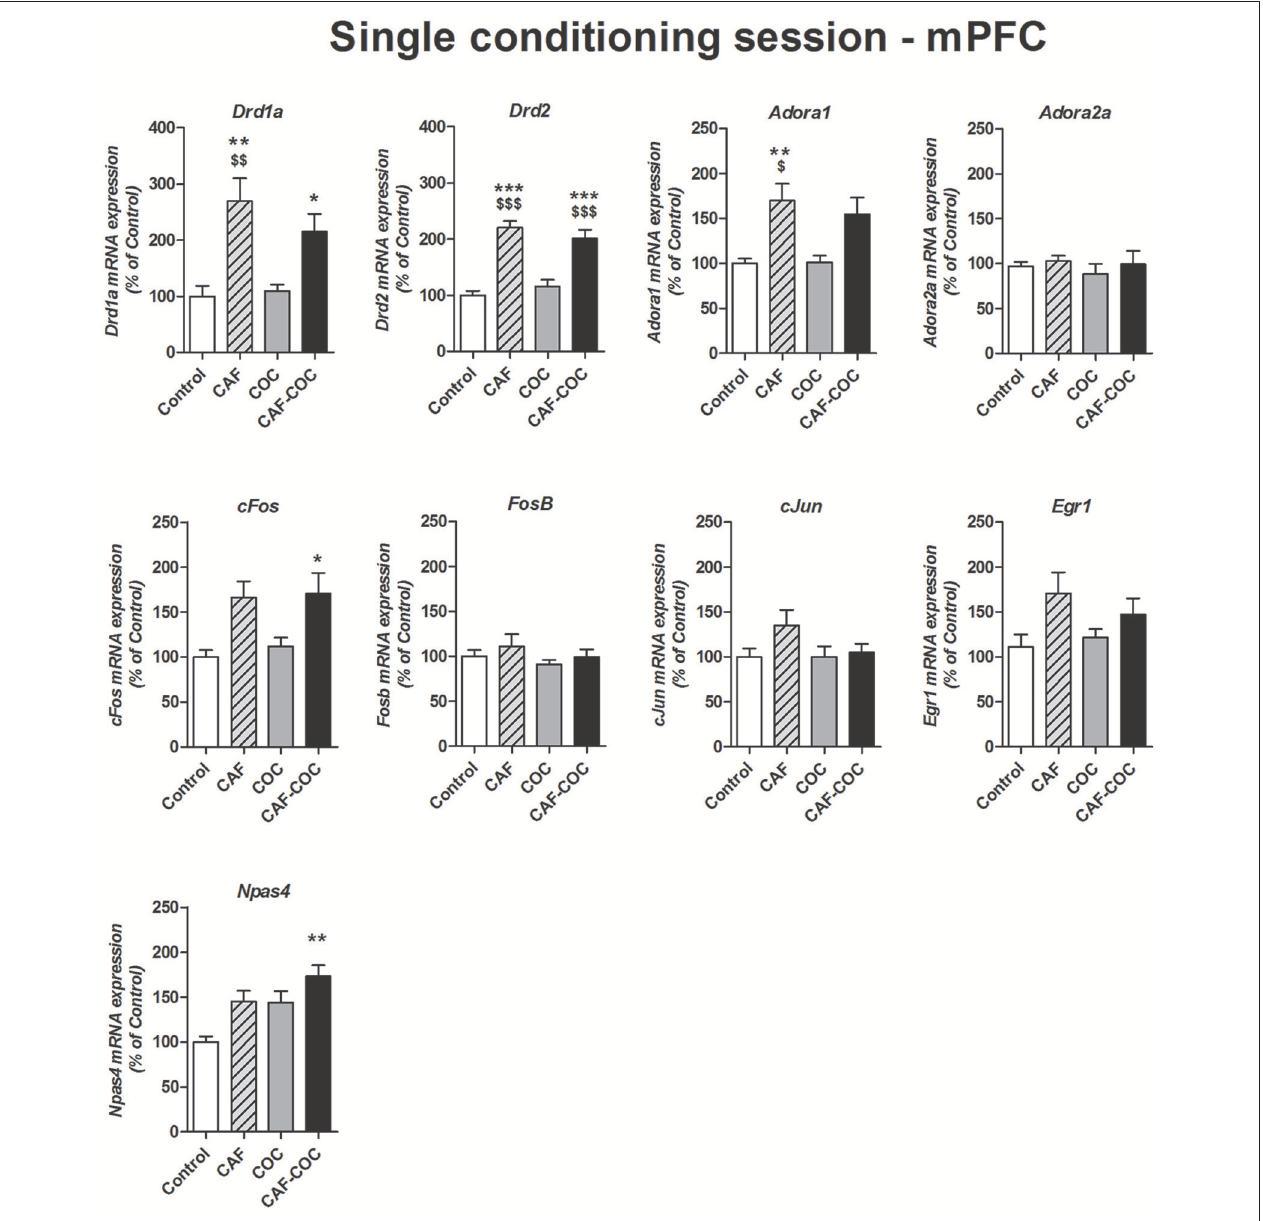
FIGURE 5 | Gene expression changes in the mPFC following a single conditioning session of the CPP. Dopamine receptor subunits Drd1a and Drd2 ; adenosine receptor subunits Adora1 and Adora2a ; IEGs FosB , cFos , cJun , Egr1 , Npas4 . Values indicate mean ± SEM. One-way ANOVA–Tukey: * p < 0.05, ** p < 0.01, *** p